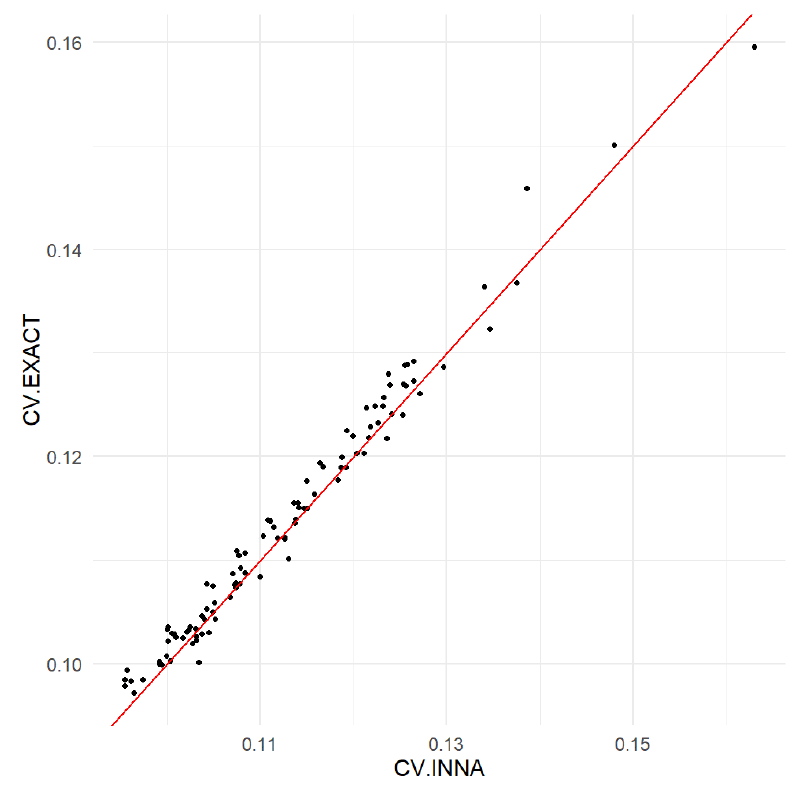
Figure 6. Comparison of the INNA method and the exact method using the CVs of the ward